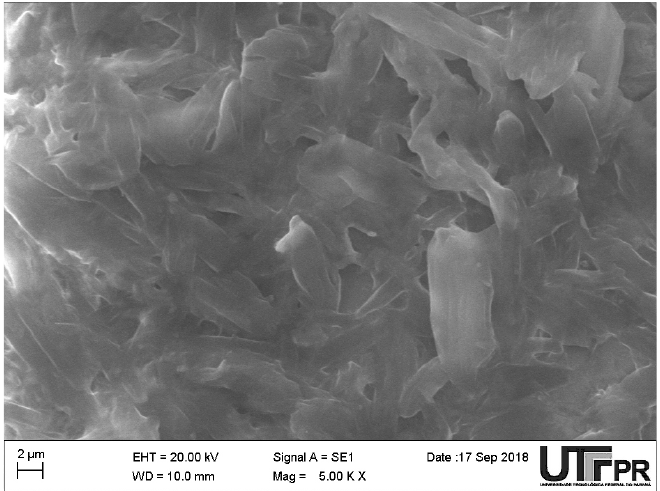
Figure 2. Microstructures of the PCDTBT:PDI observed through SEM